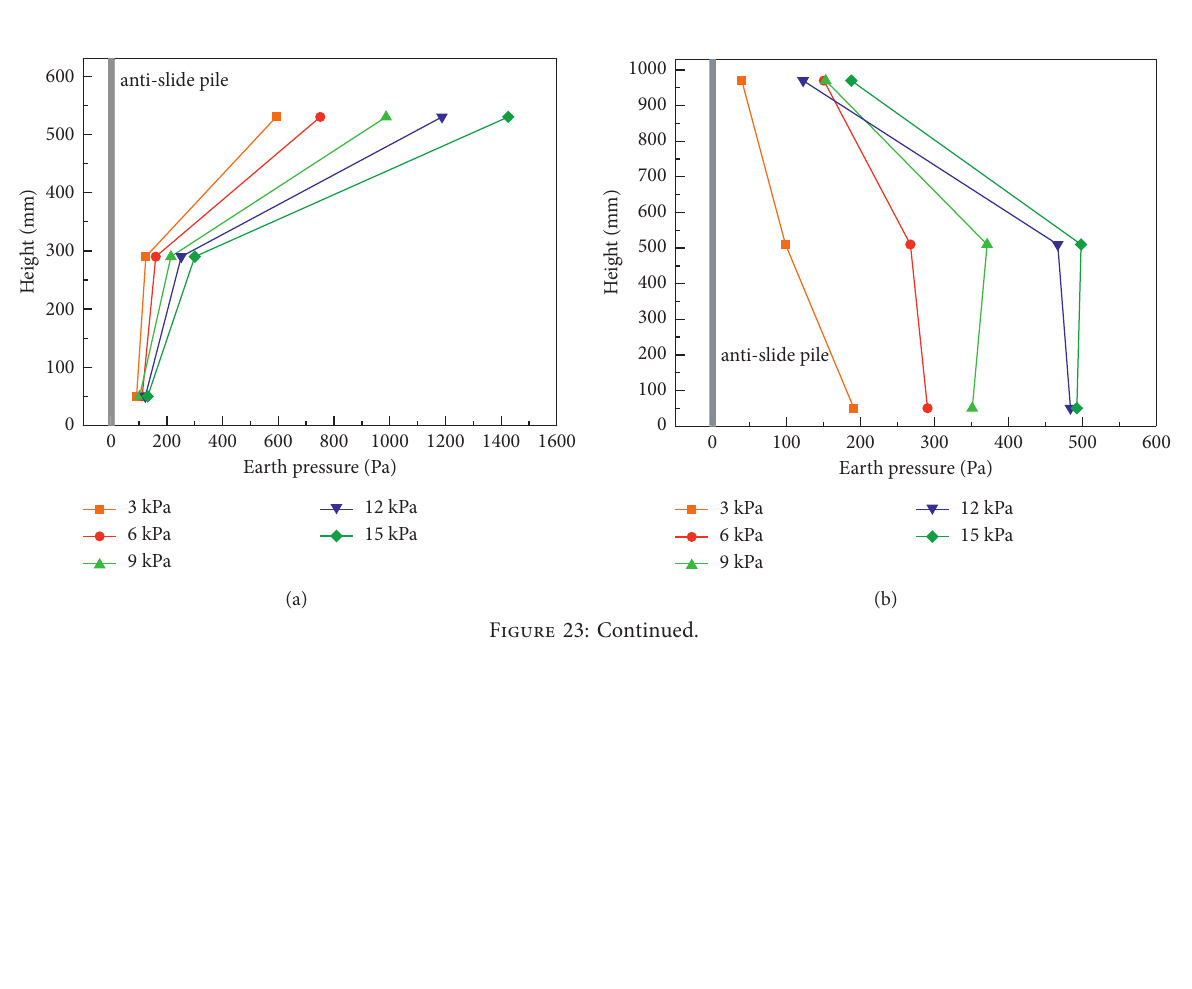
Figure 22: M y : (a) P6; (b) P8; (c) P10; (d)